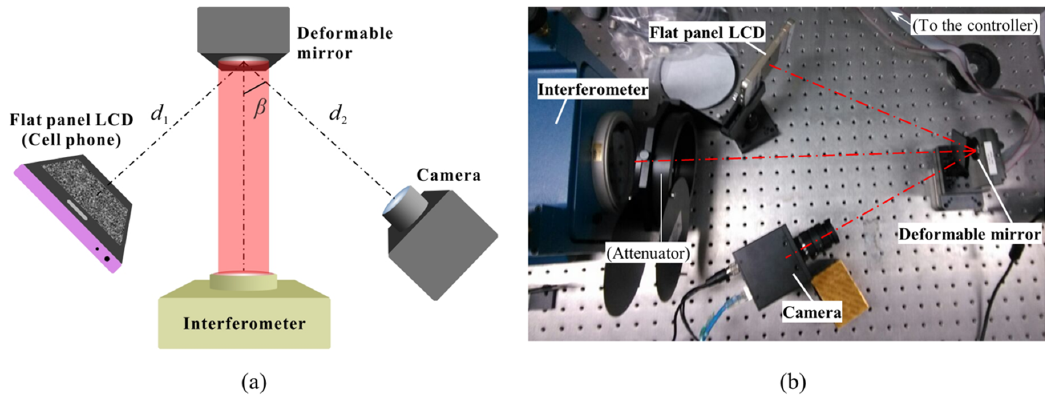
Figure 1. Setup of the DeSDIC demonstration system for measuring the deformation of the deformable mirror (top view). The camera records the reflected speckle pattern displayed on the flat-panel LCD (a cell phone screen in our case). The interferometer is for deformation measurement result comparison. ( a ) The schematic setup. ( b ) The photo of the experimental system.